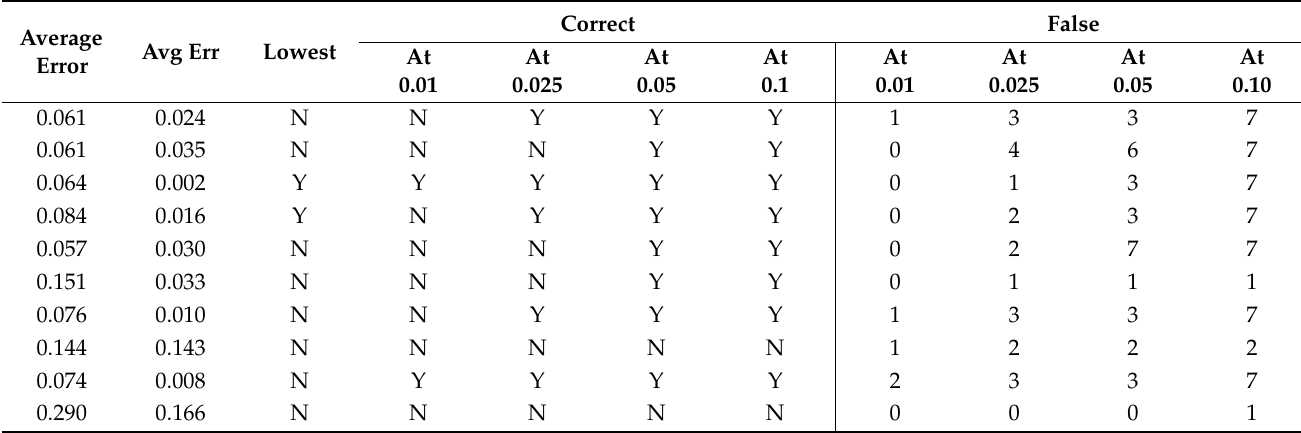
Table A60. Set 1, trials 31–40 summary data (actual PR